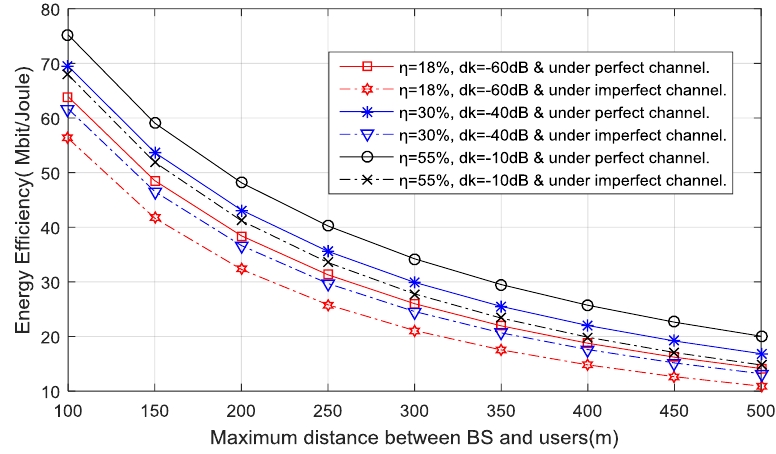
Figure 14. Energy efficiency at different distortion level and power amplifier efficiencies.